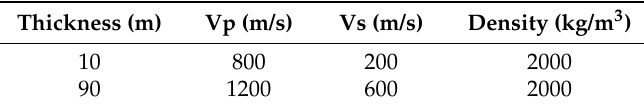
Table 3. The parameters of Model 3.